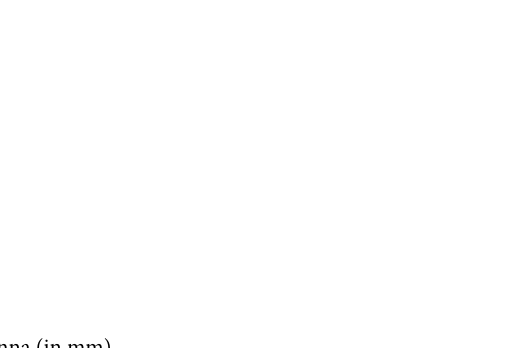
Table 3. Design parameters of the proposed antenna (in